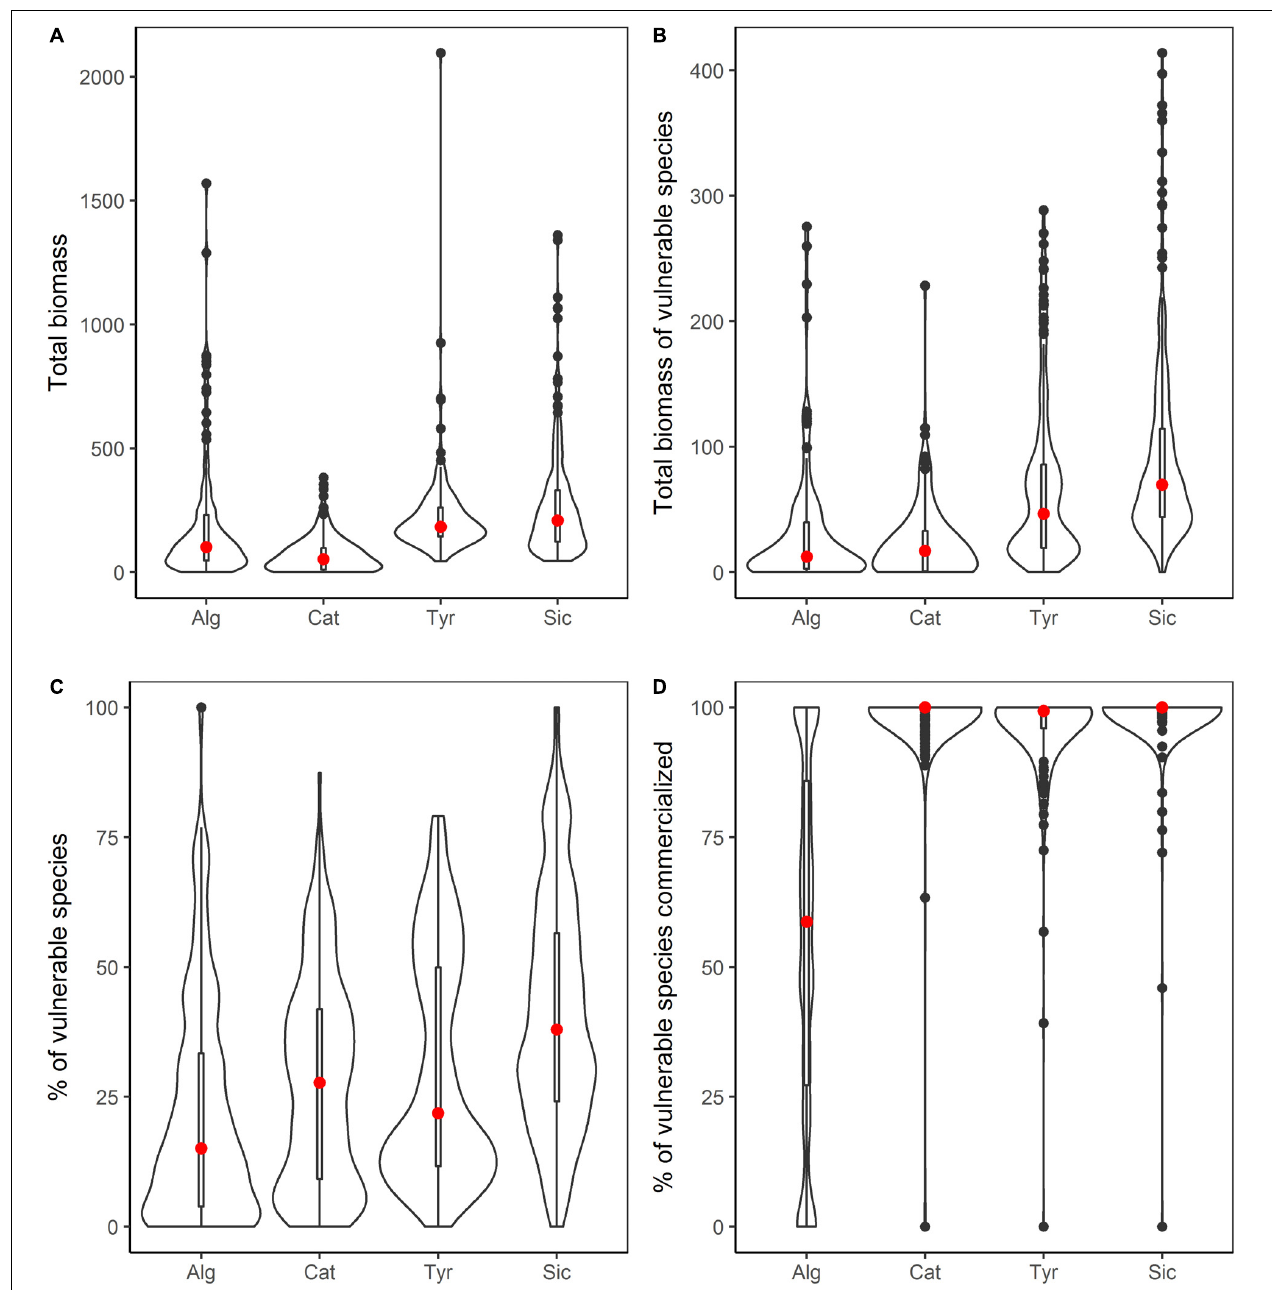
FIGURE 4 | Combined violin/boxplots summarizing data of catches made over the four study areas: Alg, Algarve ( n = 129); Cat, Catalan Sea ( n = 221); Tyr, Ligurian-North Tyrrhenian Sea ( n = 207); and Sic, Sicily Strait ( n = 275). The red dot signifies the mean and the bar indicated the interquartile range; the external line indicates data density. (A) The total biomass of catches kg per km 2 . (B) The total biomass of vulnerable species in catches kg per km 2 . (C) The Percentage of Vulnerable species in catches. (D) The percentage of vulnerable species